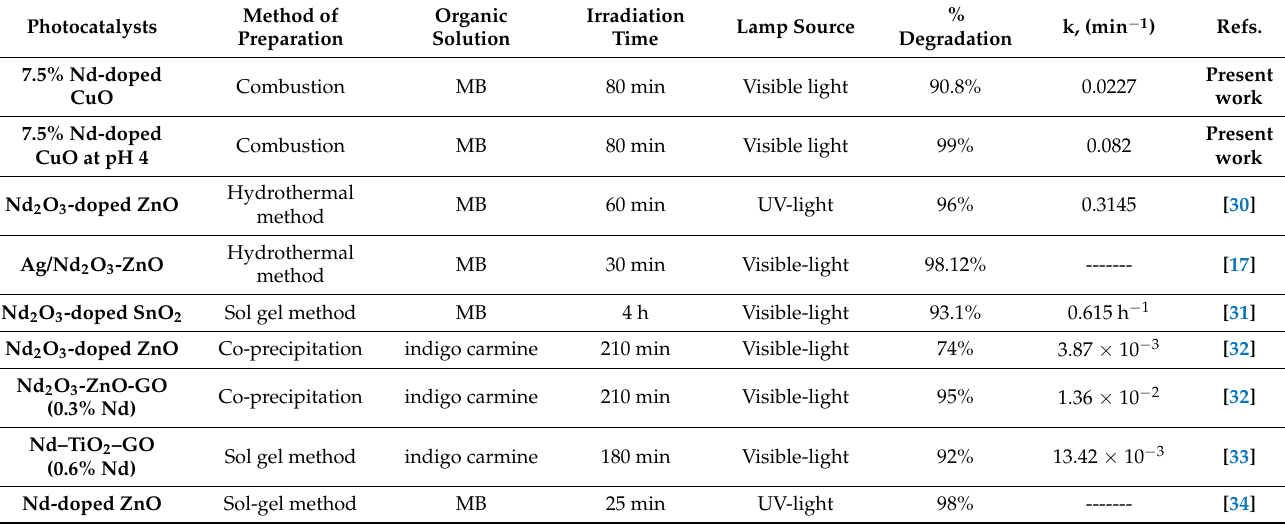
Table 5. Comparison of photocatalytic degradation of MB and different dyes in the presence of Nd 2 O 3 -doped metal oxide with other previous work